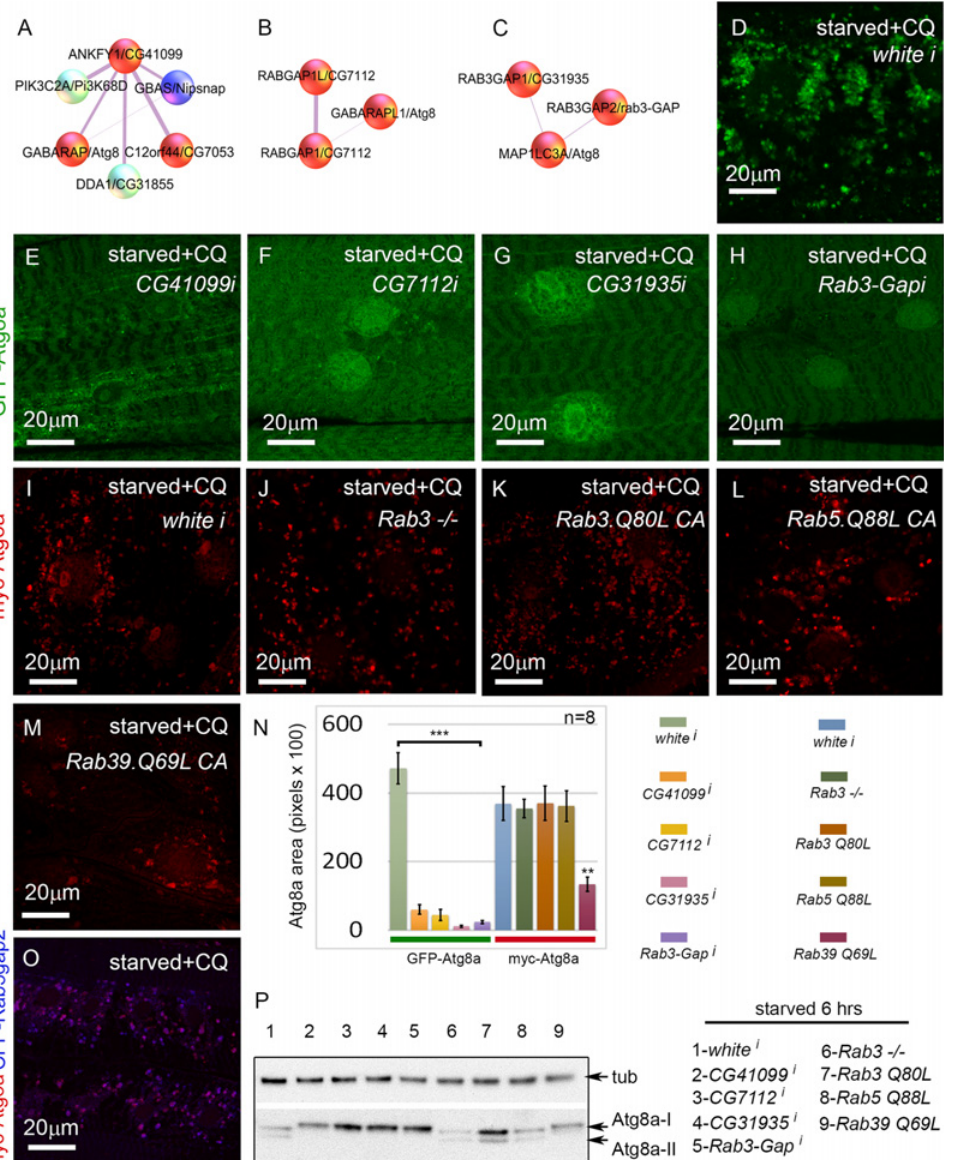
Fig 6. Rab GTPase-activating proteins and a Rab effector protein are required for autophagy in vivo . (A-C) Protein interactors of ANKFY1 ( D.m . gene = CG41099 ), RABGAP1 and RABGAP1L ( D.m gene = CG7112 ), RAB3GAP1 ( D.m . gene = CG31935 ), and RAB3GAP2 ( D.m . gene = Rab3-GAP ), identified in mammalian mass spec. Note that each of these proteins interacts with an Atg8a ortholog. D. melanogaster orthologs of other protein interactors of ANKYF1 ( D.m . genes Nipsnap and CG7053 ) were also identified as hits in the primary muscle screen. Based on our RNAi experiments red spheres are assigned to genes/proteins that promote autophagosome formation and/or expansion; blue spheres are assigned to genes/proteins that suppress autophagosome formation and/or expansion. (D-H) Dmef2-Gal4 drives expression of UAS-GFP-Atg8a in animals starved on low nutrient food for 6 hrs + 2.5 mg/ml CQ for 6 hrs. RNAi knockdown of CG41099 (E) , CG7112 (F) , CG31935 (G) , and Rab3-GAP (H) , blocks the formation of GFP-Atg8a labeled autophagosomes compared to knockdown of white (D). (I-M) Dmef2-Gal4 drives expression of UAS-myc-Atg8a in animals starved on low nutrient food for 6 hrs + 2.5 mg/ml CQ for 6 hrs. The effect of the RAB3GAPs is not via Rab3 or Rab5 function, as a Rab3 null mutation (J) , expression of a constitutive active form of Rab3 (Q80L) (K) or Rab5 (Q88L) (L) has no effect on muscle autophagy compared to control (I) . Expression of a constitutive active form of Rab39 (Q69L) (M) reduces myc-Atg8a labeled vesicles. (N) Quantification of autophagy phenotypes from panels D-M. SEM is indicated, with n = 8 ventral longitudinal muscles from individual animals and ** p < .01; *** p < .001. (O) Atg8a and Rab3-GAP colocalize to autophagosomes. Dmef2-Gal4 drives expression of UAS-myc-Atg8a and UAS-CFP-Rab3-GAP in animals starved and treated with CQ for 6 hrs. In all panels green = GFP-Atg8a and red = myc-Atg8a, and blue = CFP-Rab3Gap2. (P) Anti-Atg8a Western blot of third instar muscle lysate from Dmef2-Gal4 driving the RNAi or overexpression constructs shown in D-N. Total levels of endogenous Atg8a are variable, but only knockdown of CG41099 , CG7112 , CG31935 , Rab3-GAP , or overexpression of Rab39 (Q69L) block induction of lipidated Atg8a-II following 6 hrs